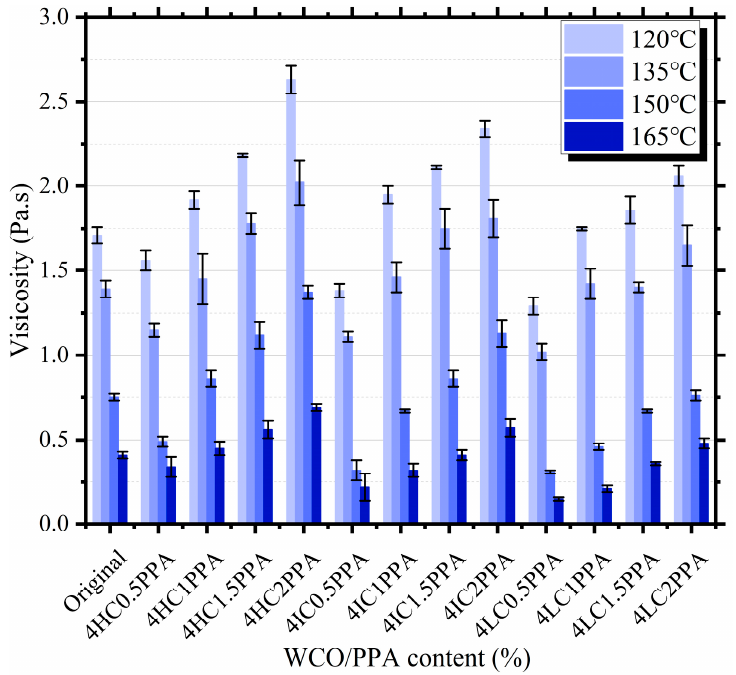
Figure 4. The Brookfield viscosity of the bitumen.